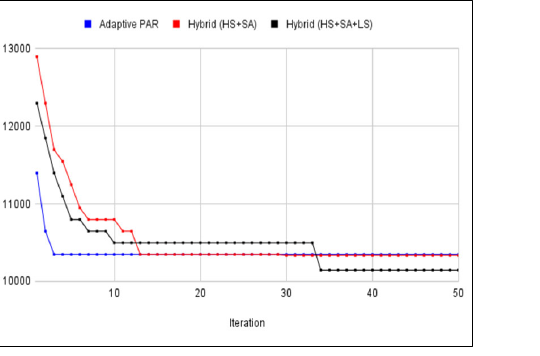
Fig. 17. Instance with 100 PM and 200 VM Fig. 18. Instance with 200 PM and 300